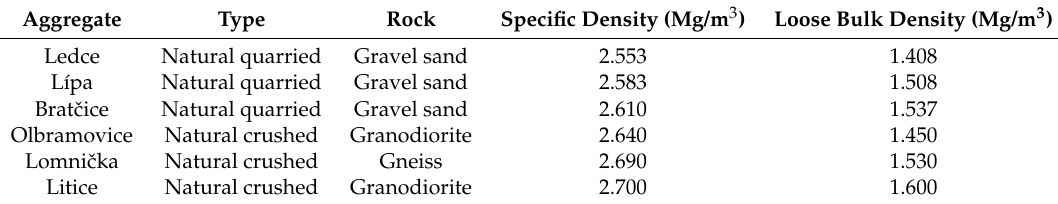
Table 4. Basic properties of used aggregates.